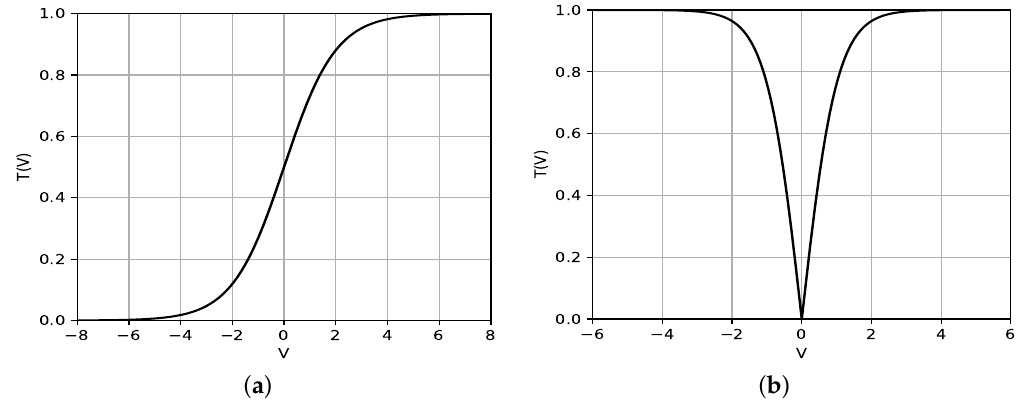
Figure 4. ( a ) S-shaped transfer function and ( b ) V-shaped transfer